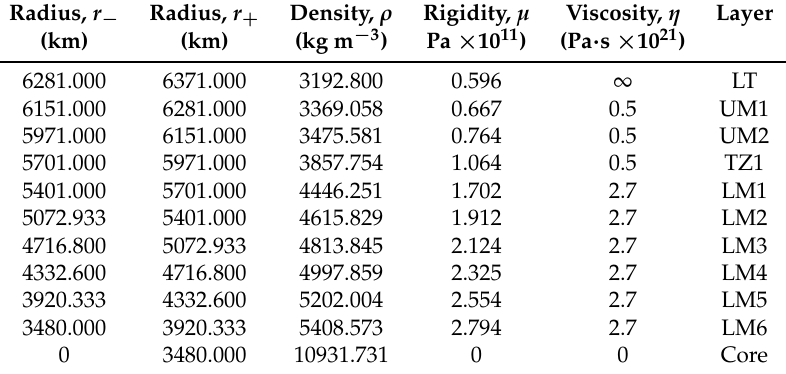
Table 2. Numerical values of the elastic (with superscript e ) and fluid (with superscript f ) loading Love numbers k L and h L for the rheological model VM2 (see Table 1), for some harmonic degrees l in l l